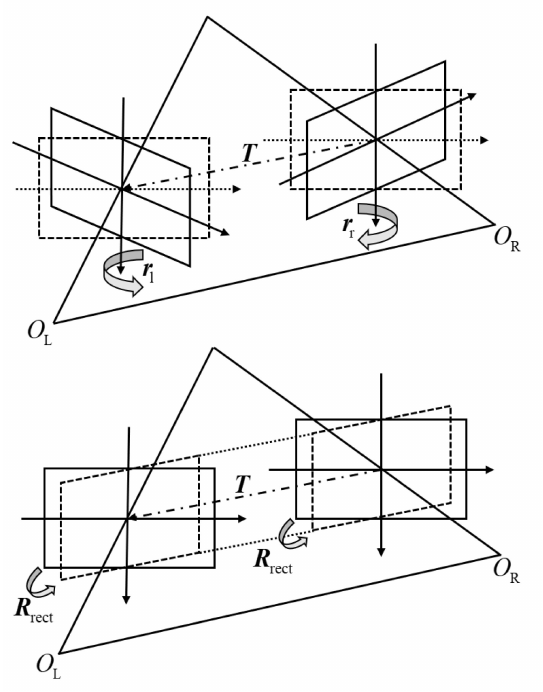
Figure 12. The process of stereoscopic correction. The rotation matrix R 3 × 3 and translation vector T 3 × 1 obtained during the process of camera calibration represent the transformation required to convert the right camera coordinate system to the left camera coordinate system. In order to minimize the image reprojection distortion, we rotate the imaging plane of the left and right cameras by half R 3 × 3 . The rotation matrices of the left and right cameras are represented by r respectively. The relationship between r l and r r is mathematically expressed